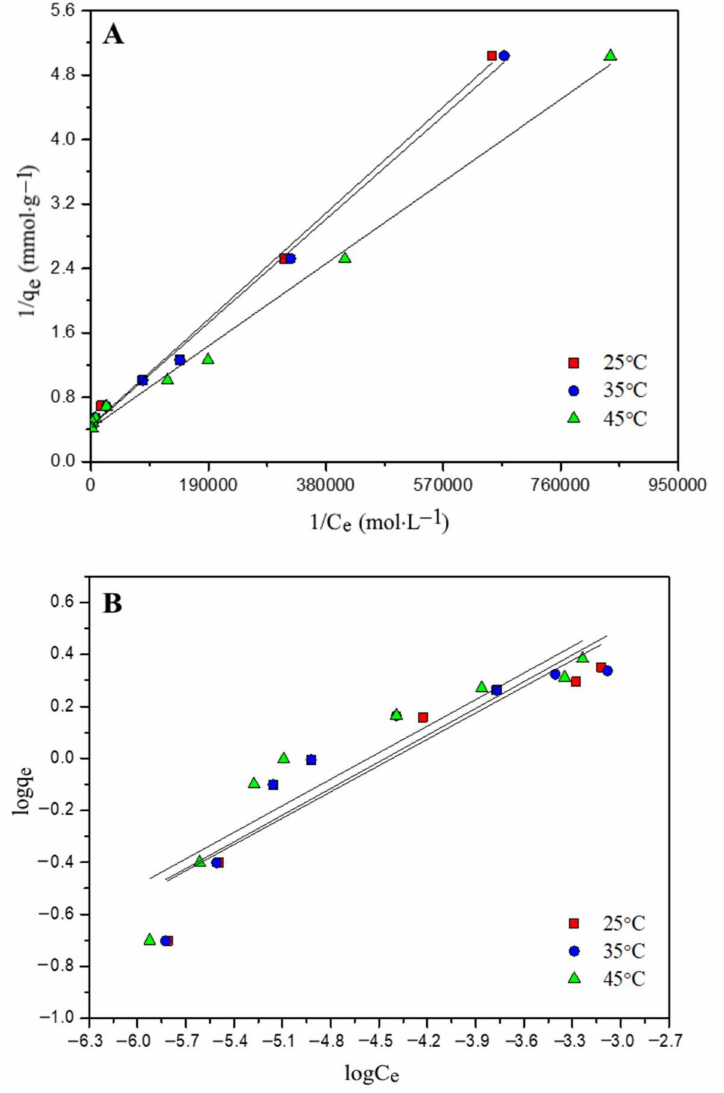
Figure 4. Langmuir ( A ) and Freundlich ( B ) adsorption isotherms of 2-NP on DKLAAC at different temperatures (25 ◦ C, 35 ◦ C, and 45 ◦